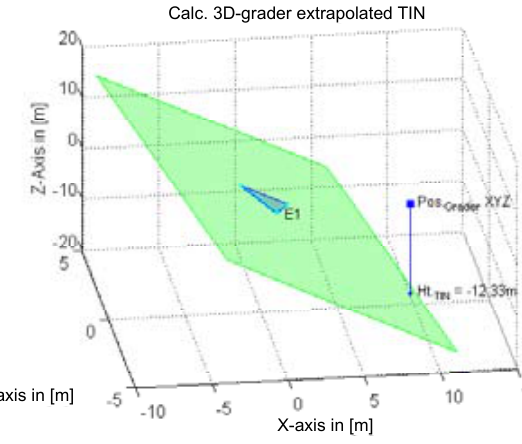
Fig. 10. Calculation of height in one TIN triangle